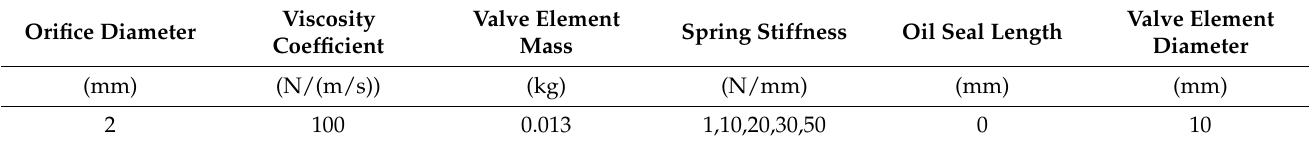
Table 4. Simulation parameters—group